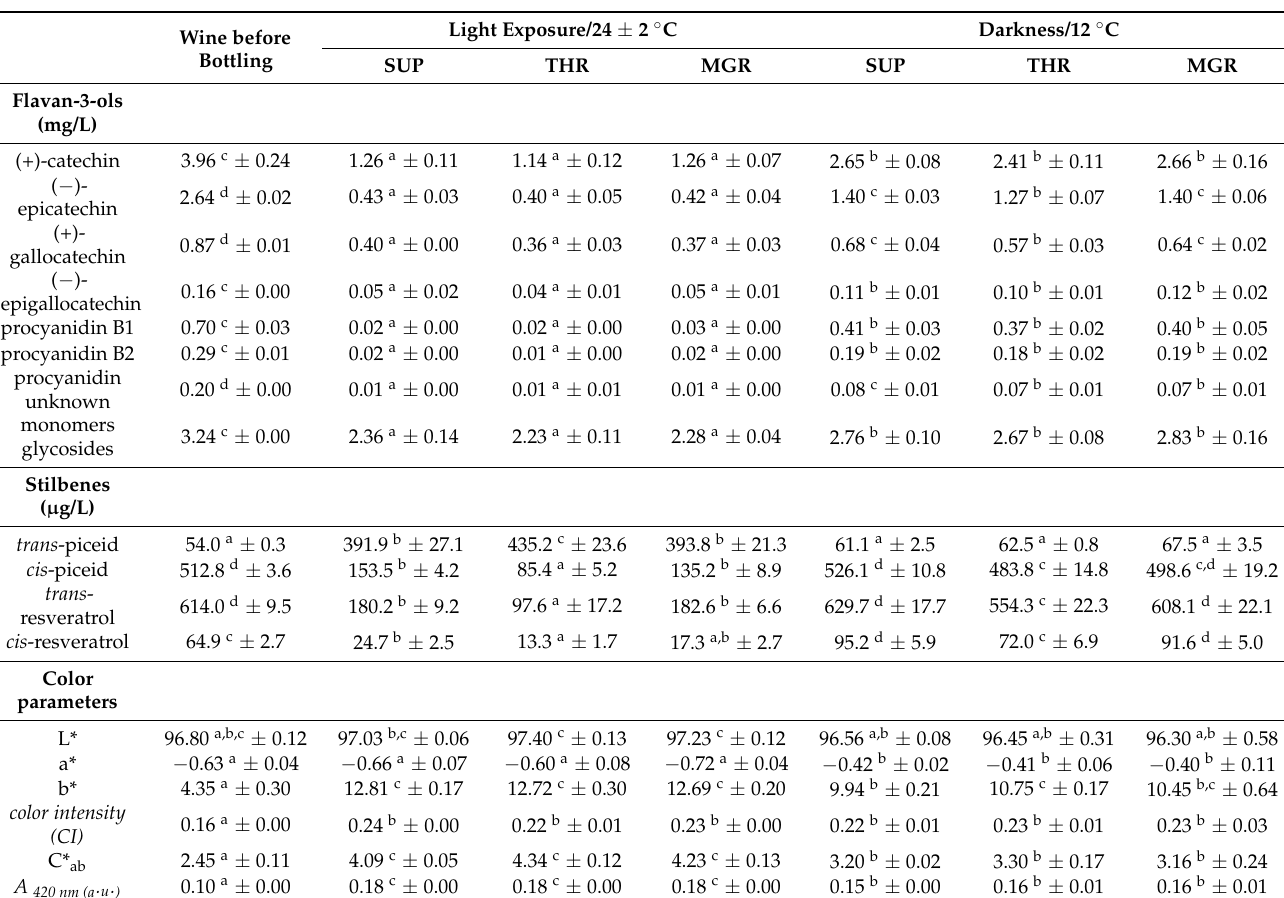
Table 2. Flavan-3-ols (mg/L), stilbenes ( µ g/L) and color-related parameters in wines before bottling and storage for one year under the different conditions tested. SUP: super quality natural corks; THR: third quality natural corks; MGR: microgranulated